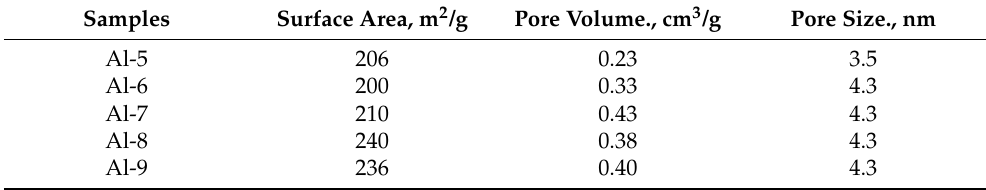
Table 4. Textural properties of Al 2 O 3 samples prepared at various pH values.